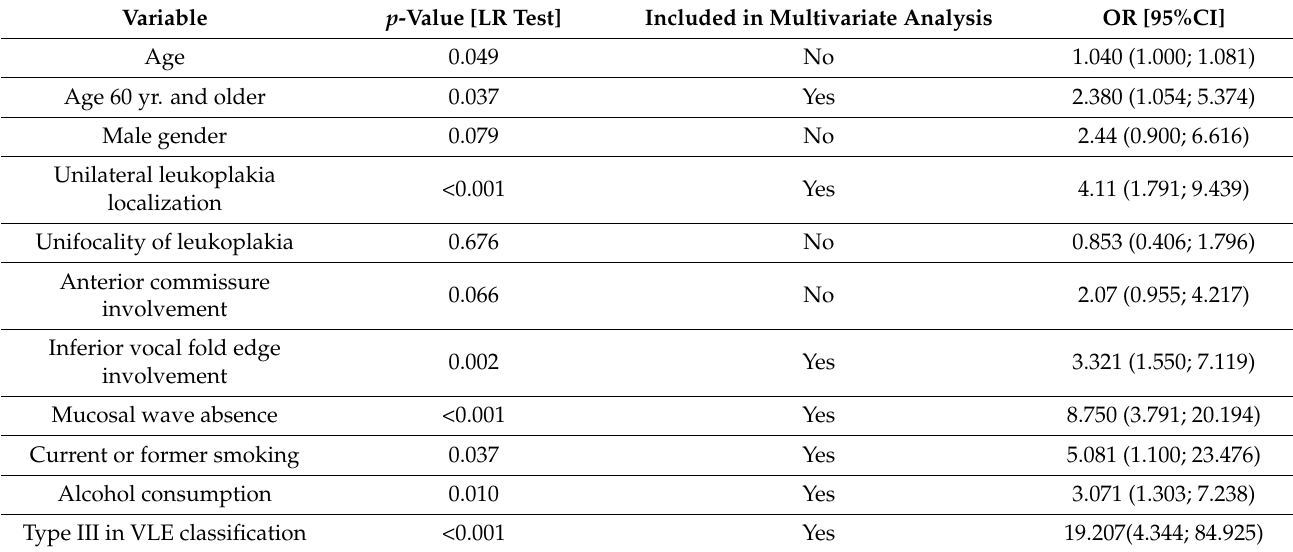
Table 4. Summary of univariate analysis conducted as the first step toward formulating a logistic regression model. LR—likelihood ratio test; OR—odds